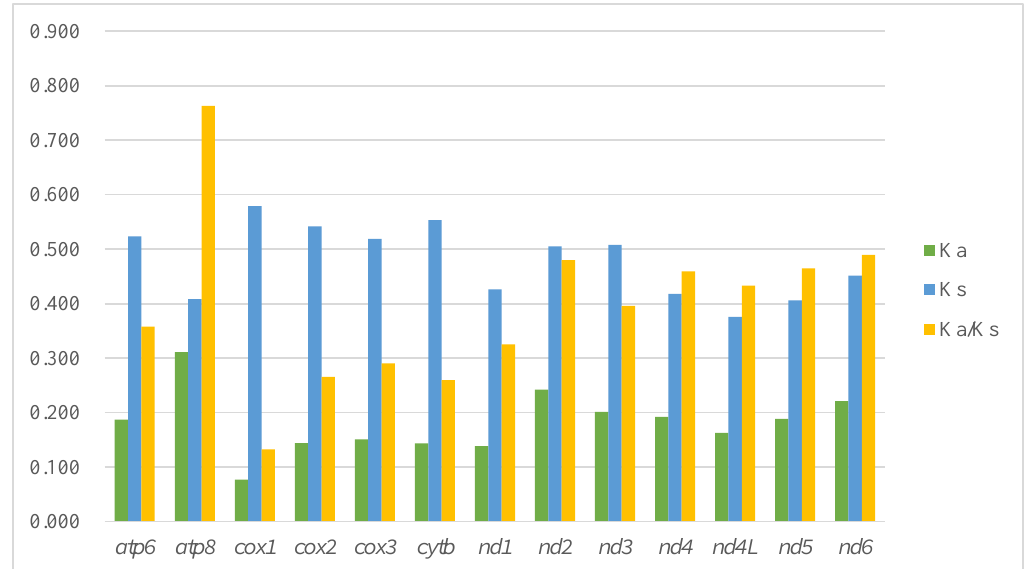
Figure 4. The evolutionary rate of each PCGs in the mitogenomes of 18 treehoppers in this study. Ka is the nonsynonymous nucleotide substitutions per nonsynonymous site, Ks is the synonymous nucleotide substitutions per synonymous site, and Ka/Ks is the ratio of the rate of nonsynonymous substitutions to synonymous substitutions.